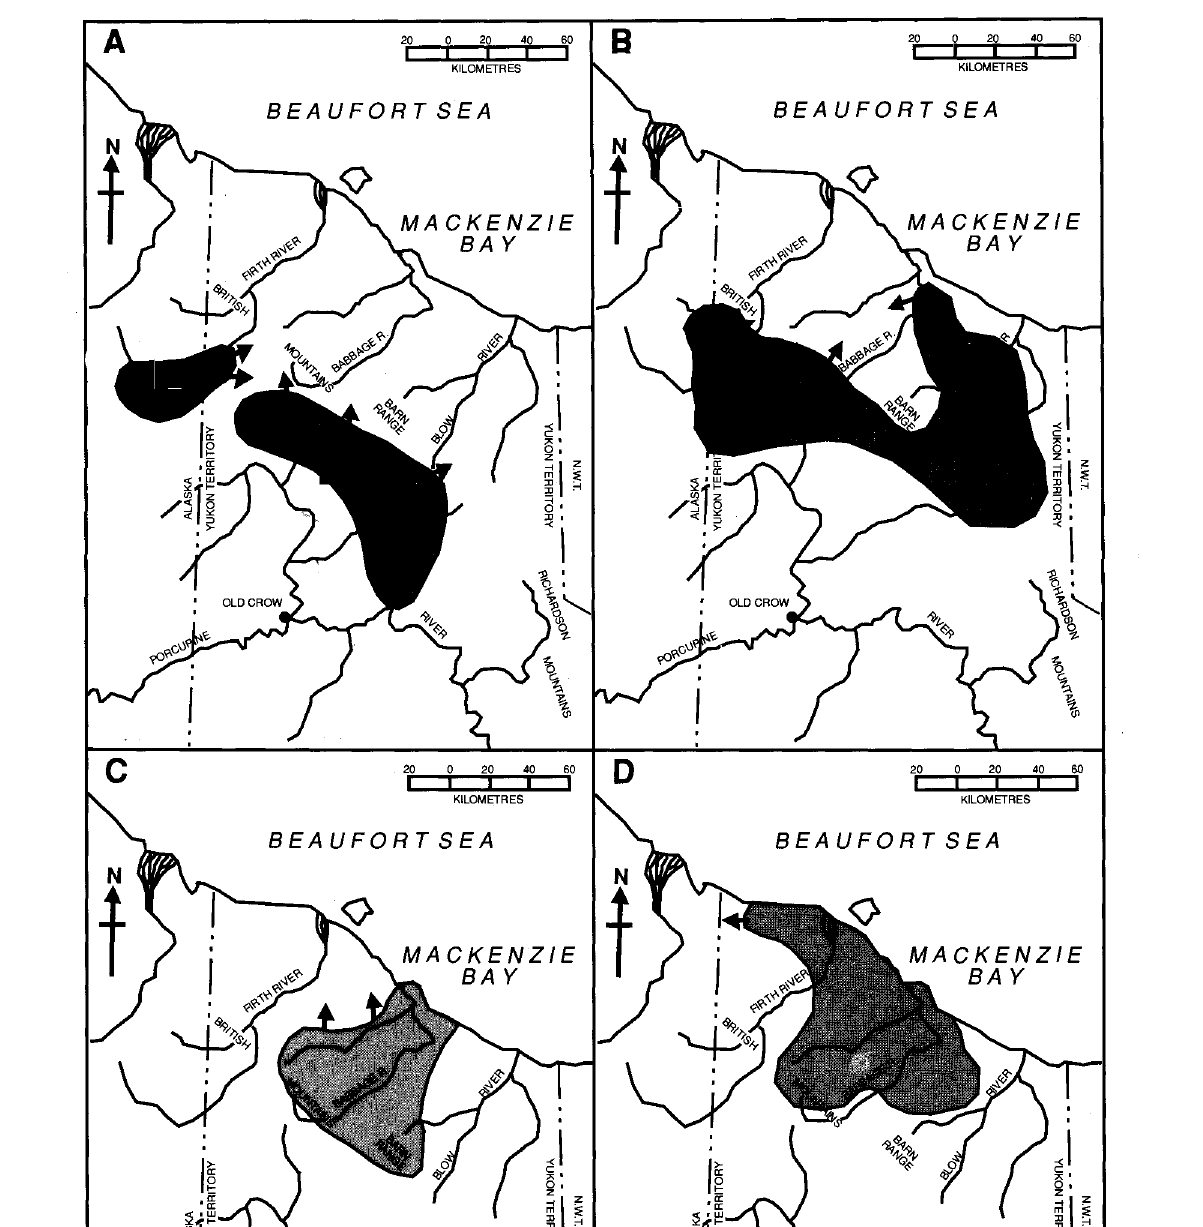
Figure 3.12. General distribution and direction of movement of male caribou in northern Yukon in late May (A), early June (B), mid June (C), and late June